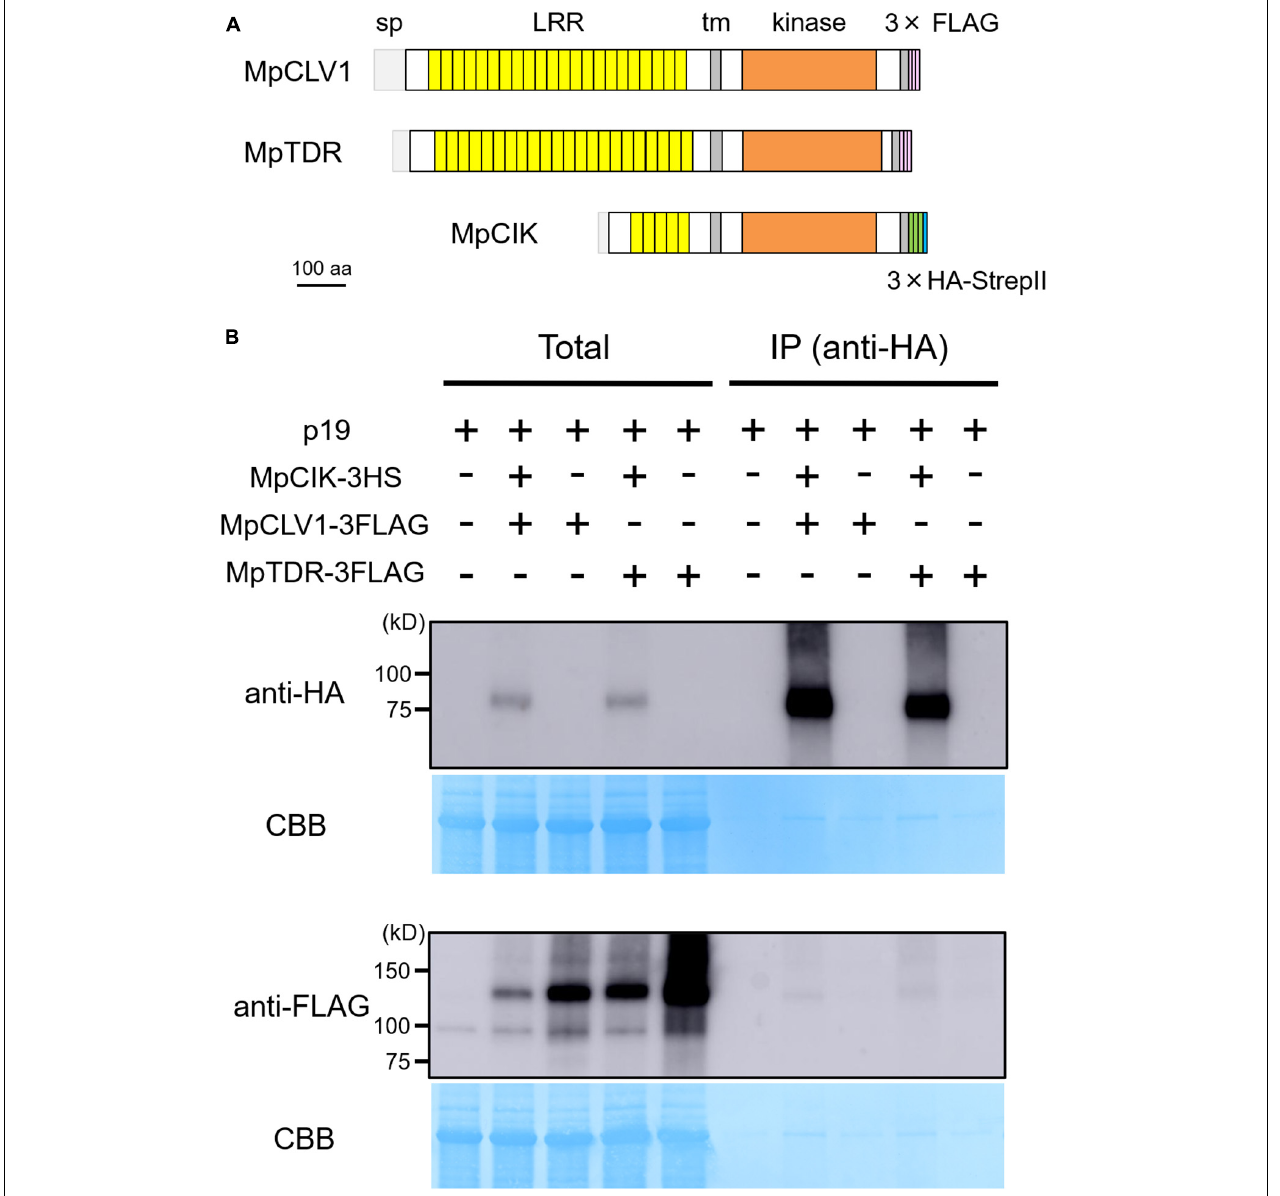
FIGURE 4 | MpCIK weakly associates with MpCLV1 and MpTDR in N. benthamiana. (A) Schematic illustration of expressed receptors. (B) Co-immunoprecipitation experiment using anti-HA affinity matrix. The indicated combinations of MpCIK-3HS, MpCLV1-3FLAG and MpTDR-3FLAG constructs, together with p19 silencing suppressor, were transiently expressed in N. benthamiana . Total proteins were extracted and immunoprecipitated with anti-HA affinity matrix. Immunoblot analyses were performed using anti-HA or anti-FLAG antibody. In the presence of MpCIK-3HS, MpCLV1-3FLAG and MpTDR-3FLAG were co-precipitated with anti-HA affinity matrix. This experiment was repeated twice with similar